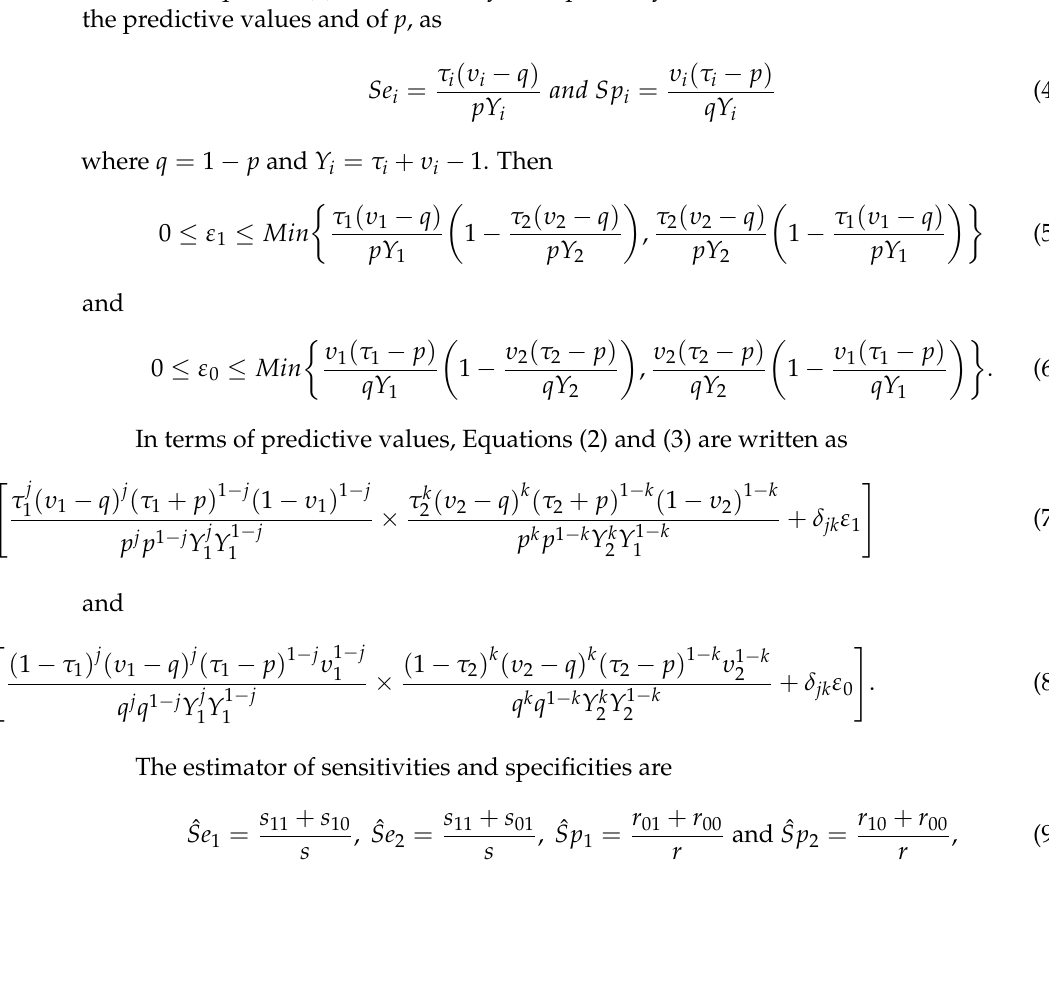
Table 1. Observed frequencies subject to a paired design. T 1 = 1 T 1 = 0 Diseased ( D = 1) s 11 s 10 s 01 s 00 s Non-diseased ( D = 0) r 11 r 10 r 01 Total s 11 + r